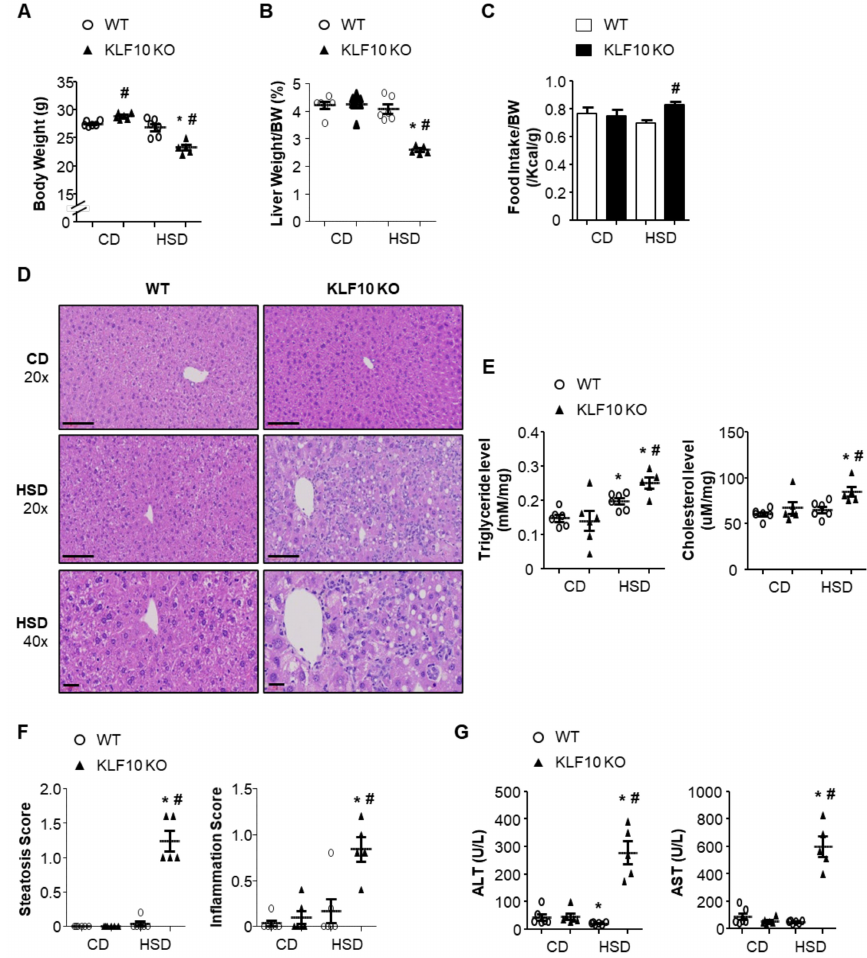
Figure 1. Klf 10 KO mice develop HSD-induced liver injury. Eight-week-old WT and Klf 10 KO mice were fed either CD or HSD for eight weeks (n = 5–6 mice/group). ( A ) Body weights and ( B ) liver weights were determined after eight weeks of either diet. ( C ) Food intake (average over seven days) was measured in WT and Klf 10 KO mice. ( D ) Representative histological images of H&E-stained liver sections (Scale bars: 60 µ m, Magnification: 20 × ; enlarged images in the bottom panels of D, 40 × ). ( E ) Triglycerides and cholesterol in the liver were measured from liver samples. ( F ) The grade of the steatosis and inflammation score was calculated. ( G ) Plasma ALT and AST levels were measured as liver injury markers. All data are representative of at least three independent experiments and expressed as mean ± SEM. Charts were produced using GraphPad Prism 5.0. Statistical differences were determined by two-way ANOVA with Mann–Whitney U test using SPSS v17.0. * p < 0.05 vs. genotype-matched, CD-fed group and # p < 0.05 vs. diet-matched, genotype control. WT, wild type; KO, knockout; CD, control chow diet; HSD, high-sucrose